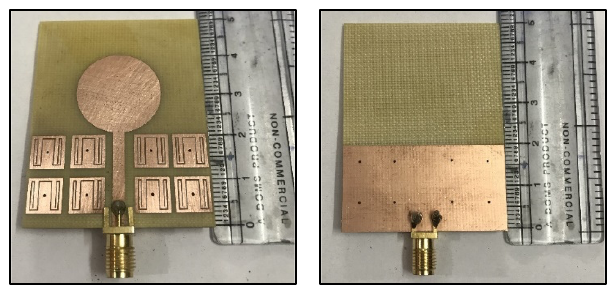
Figure 15. Designed UWB-CMSA with M-shaped EBG near the feed.